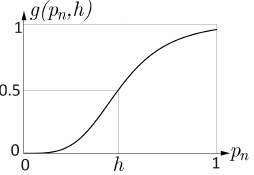
Figure 1: The weight function g ( p n ; h ) ; note that g ( h; h ) = 0 : 5